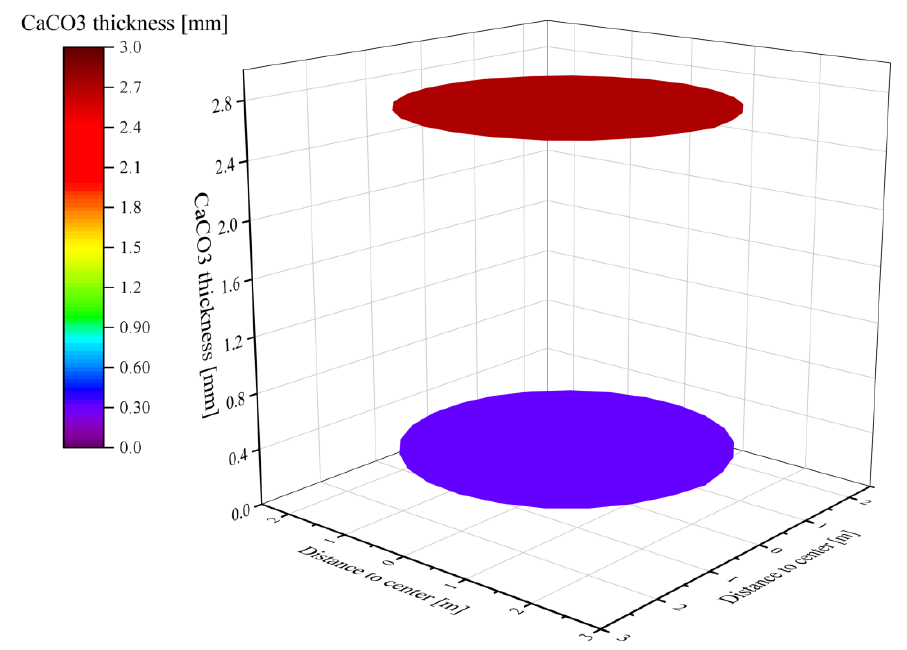
Figure 10. Thickness and distribution of CaCO 3 of 80 mm particles ( up ) and 40 mm particles ( down ) at the outlet of the calcination zone.